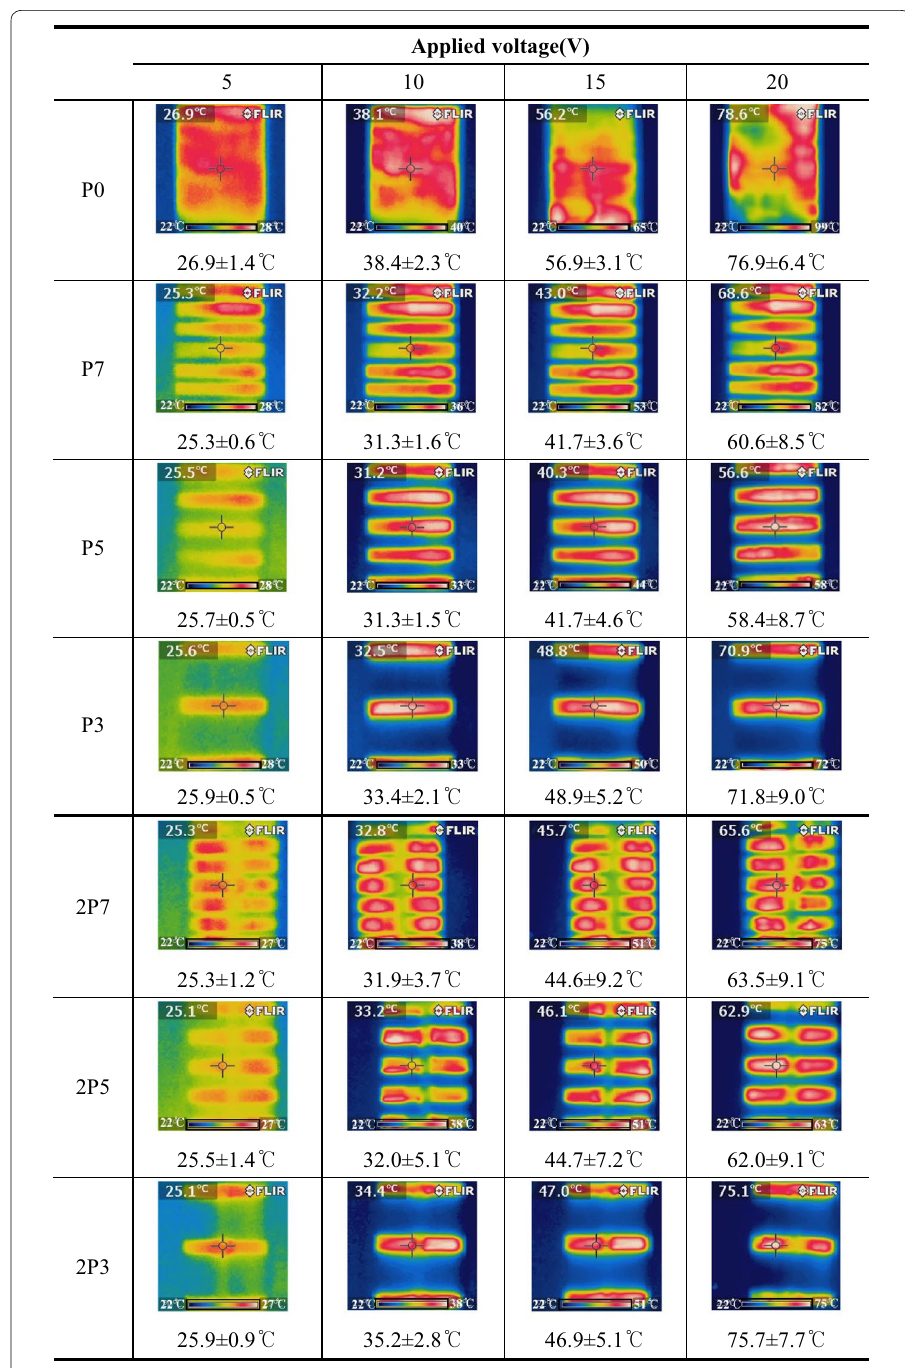
Fig. 4 IR thermal image of surface temperatures at various applied voltages of the CNF/PVDF-HFP composite coated on cotton fabrics with various circuit